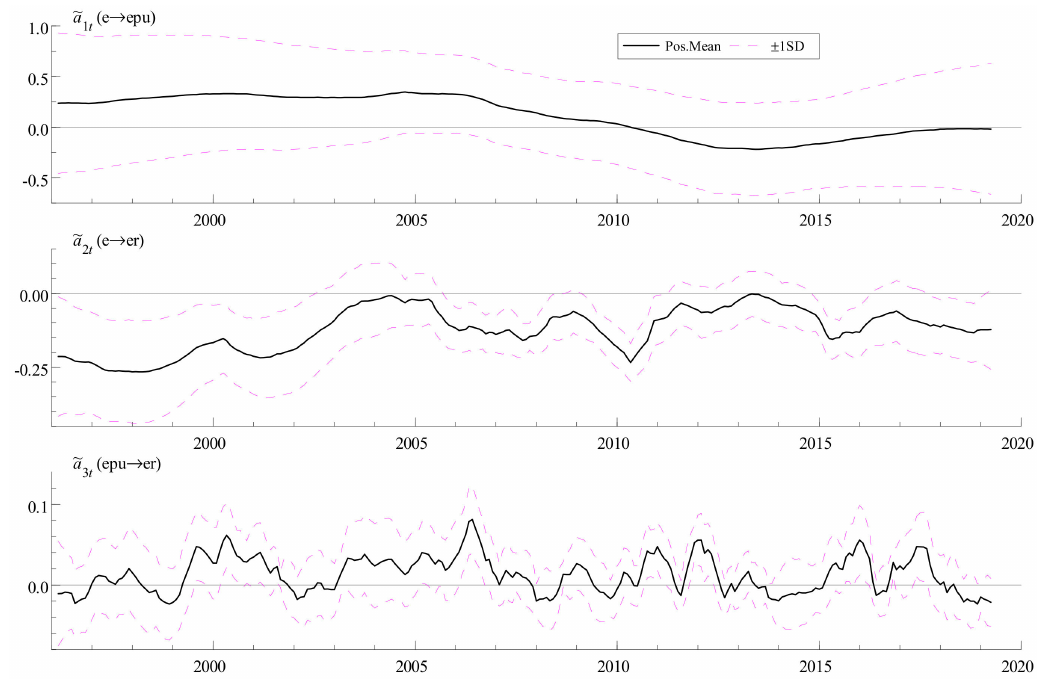
Figure 1. Posterior estimates for simultaneous